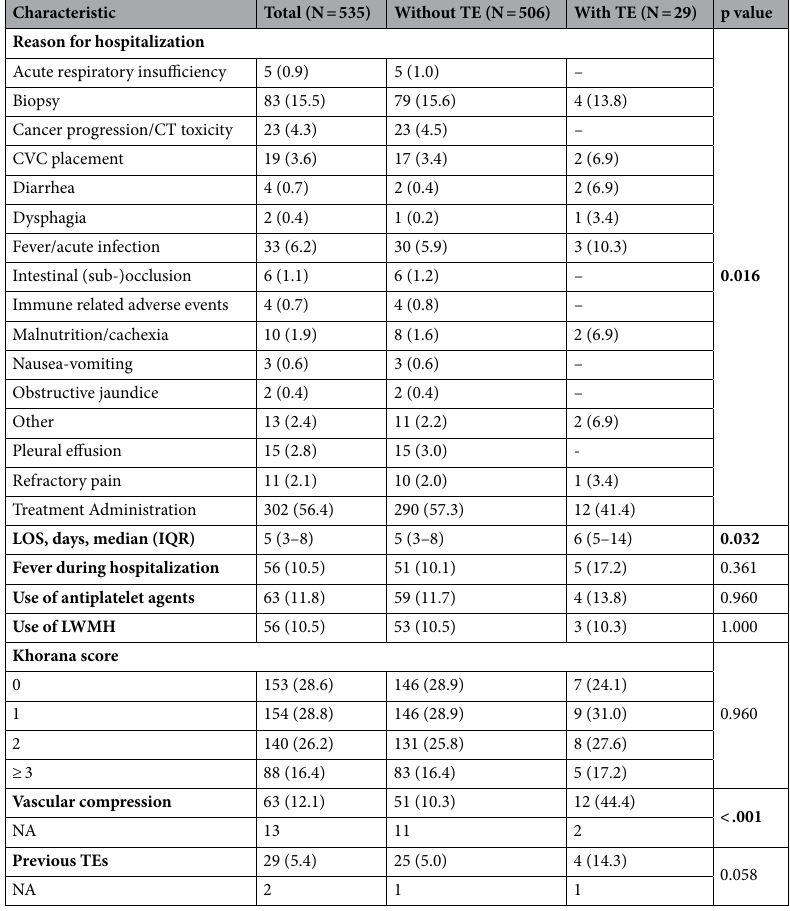
Table 1. Baseline patients’ characteristics in the whole case series and according to the presence or absence of TE events. Data are presented as n (%) except where otherwise noted. The p value of the χ 2 test, Fisher’s exact test o WMW test assessing the association between each characteristic and the occurrence of TE events is indicated in the right column of the table. The p value of the test is indicated in bold numbers when